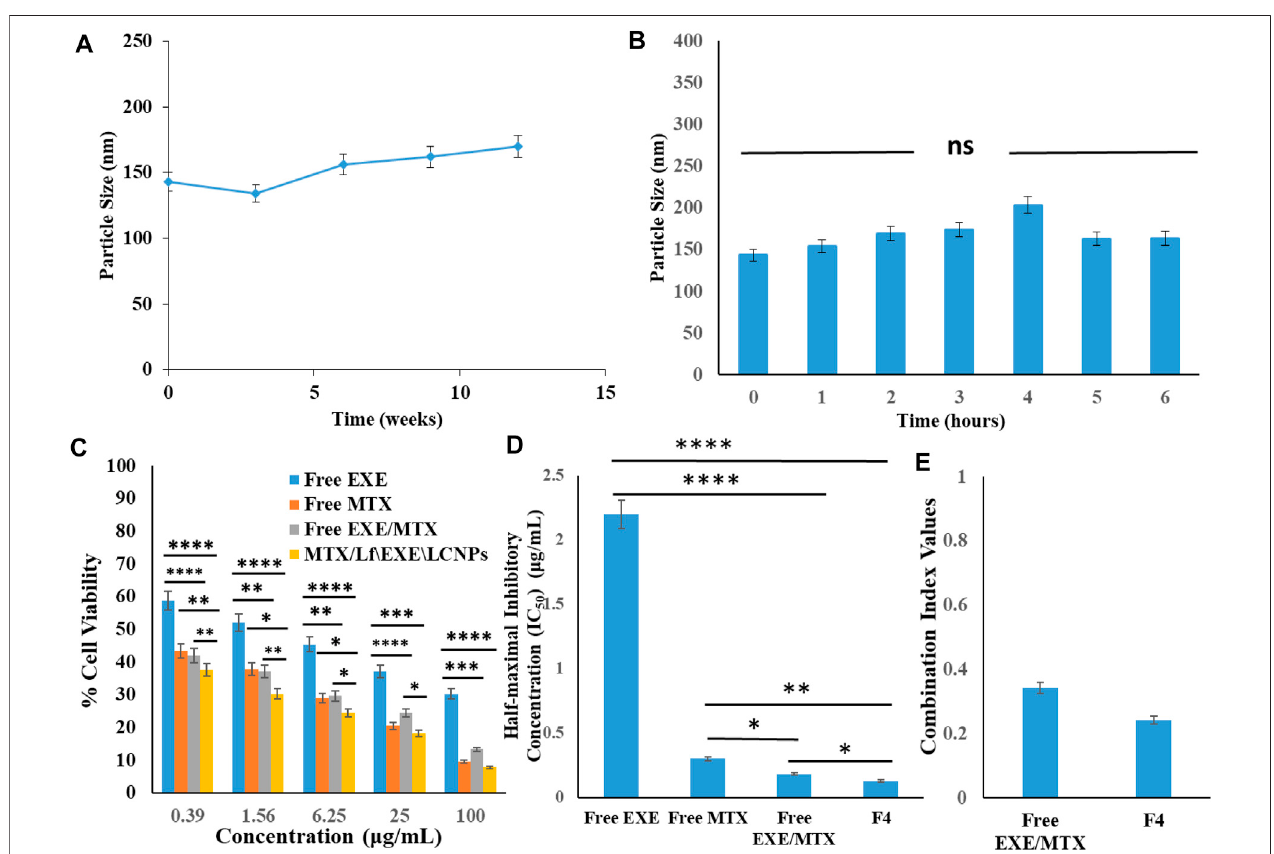
FIGURE 6 | (A) Physical stability of MTX/Lf\EXE\LCNPs F4 showing the change in particle size with time (3 months) ( n = 3). (B) In vitro serum stability of MTX/ Lf\EXE\LCNPs F4 in 10% fetal bovine serum (FBS) solution according to PS measurements at different time intervals using DLS ( n = 3). (C) Cytotoxicity analysis of free EXE, free MTX, and freeEXE/MTX compared to targeted MTX/Lf\EXE\LCNPs F4 on MCF-7 breast cancer cell line after 24 h ( n = 3). (D) IC 50 of free EXE, free MTX, EXE/ MTXcombination,andMTX/Lf\EXE\LCNPs F4 ( n =3). (E) CombinationIndex(CI)offreedrugscombinationandMTX/Lf\EXE\LCNPs F4 ( n =3).(ns,non-signi fi cant; * p < 0.05; ** p < 0.01; *** p < 0.001; **** p <